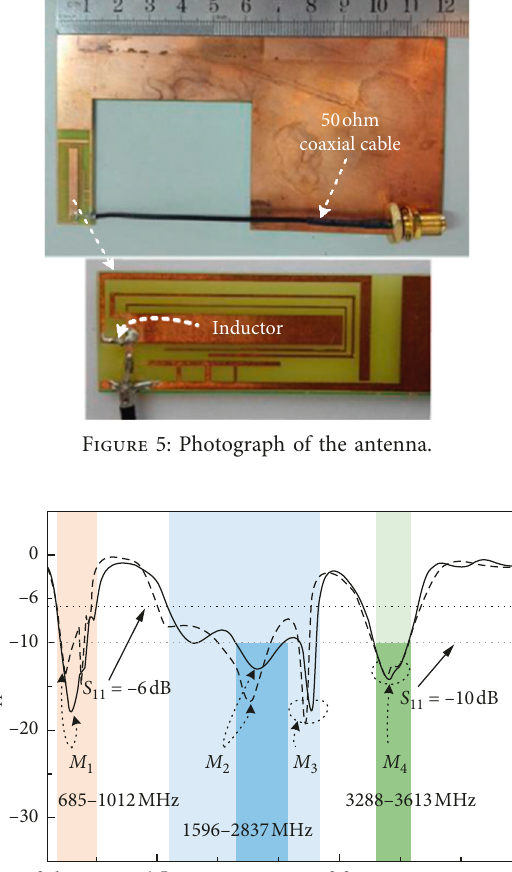
11 of the proposed antenna.